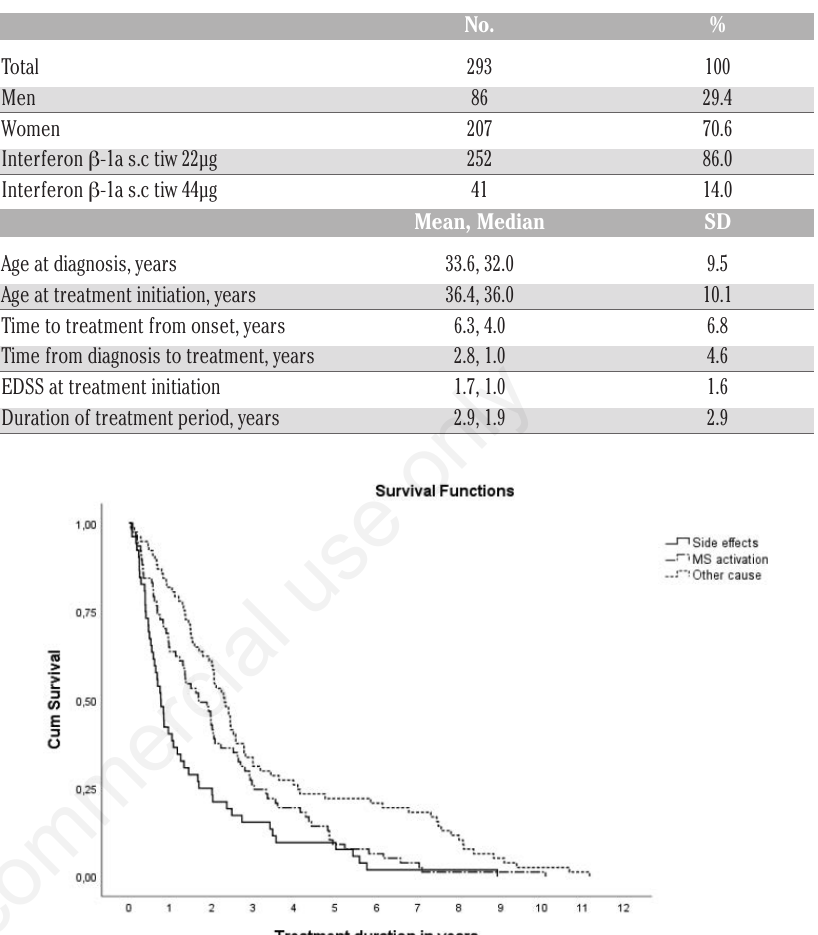
Figure 1. Time from interferon β -1a. s.c tiw start to discontinuation by cause. K-M curve. Time to discontinuation (years) of treatment (n=206) in groups: Side effects (n=52), MS activation (n=77) and other causes (n=77).